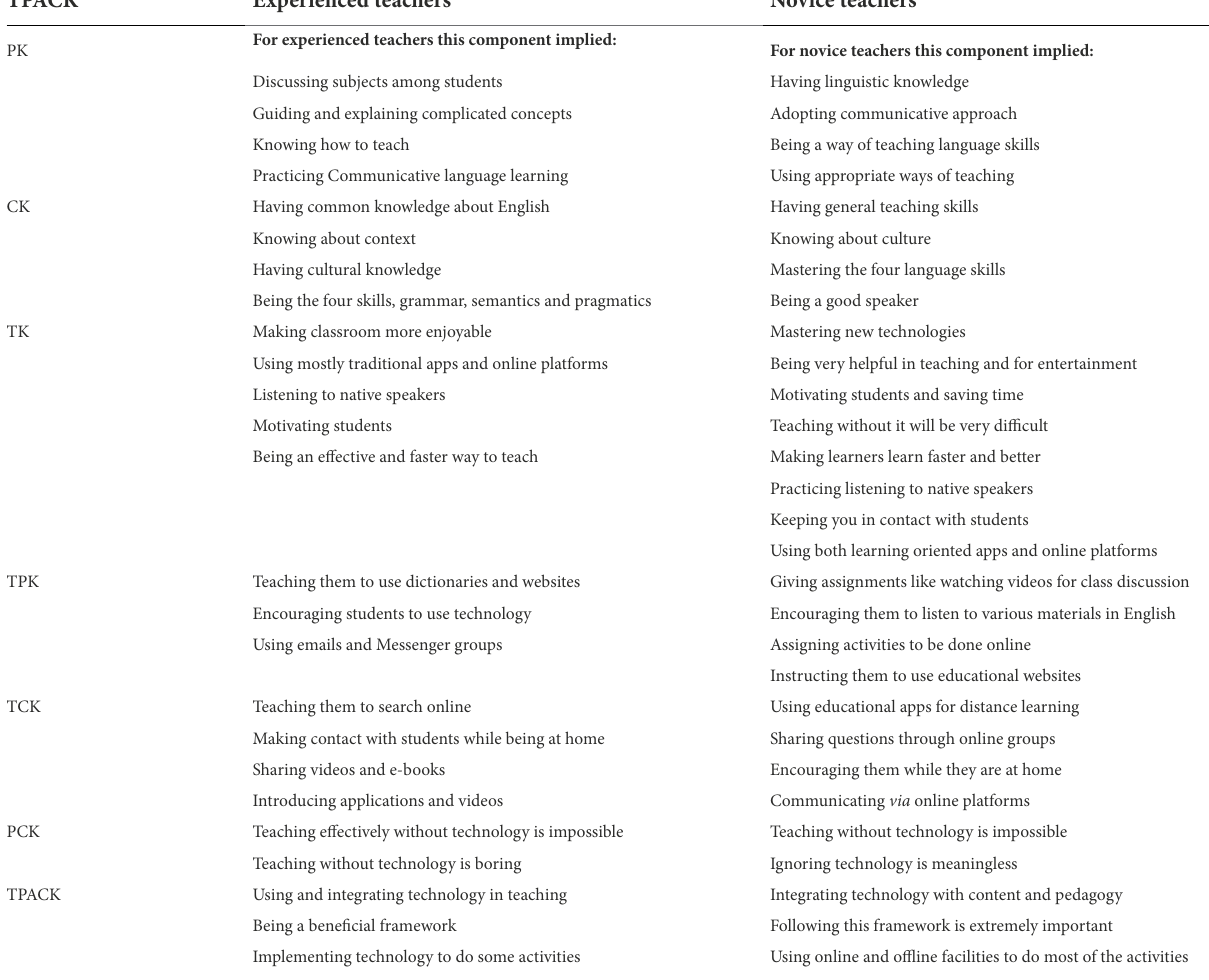
TABLE 2 Experienced and novice teachers’ beliefs about TPACK